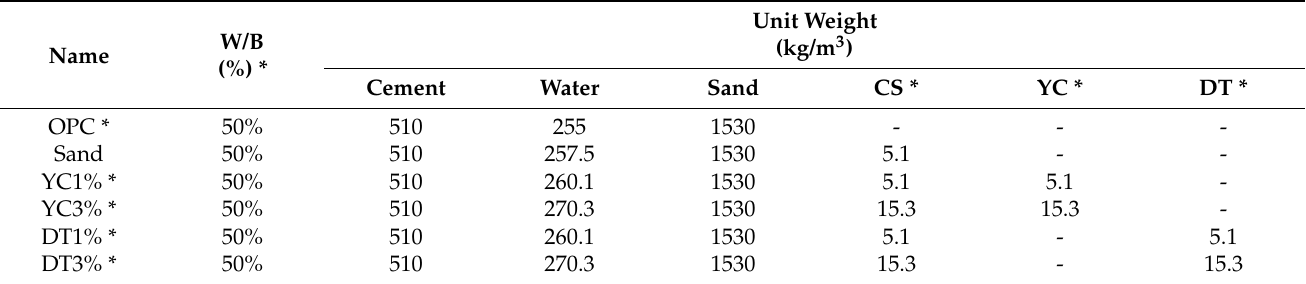
Table 2. Mix proportion of the cement